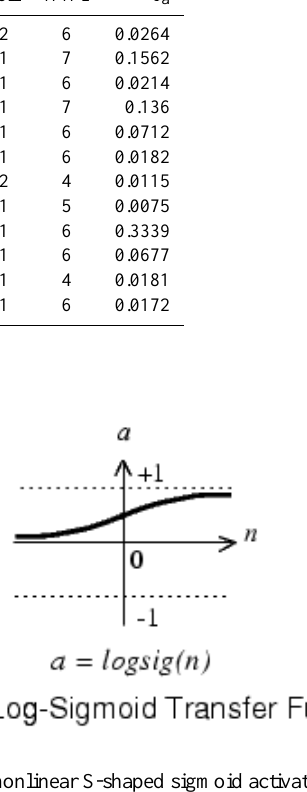
Fig. 3. The nonlinear S-shaped sigmoid activation function used in the present